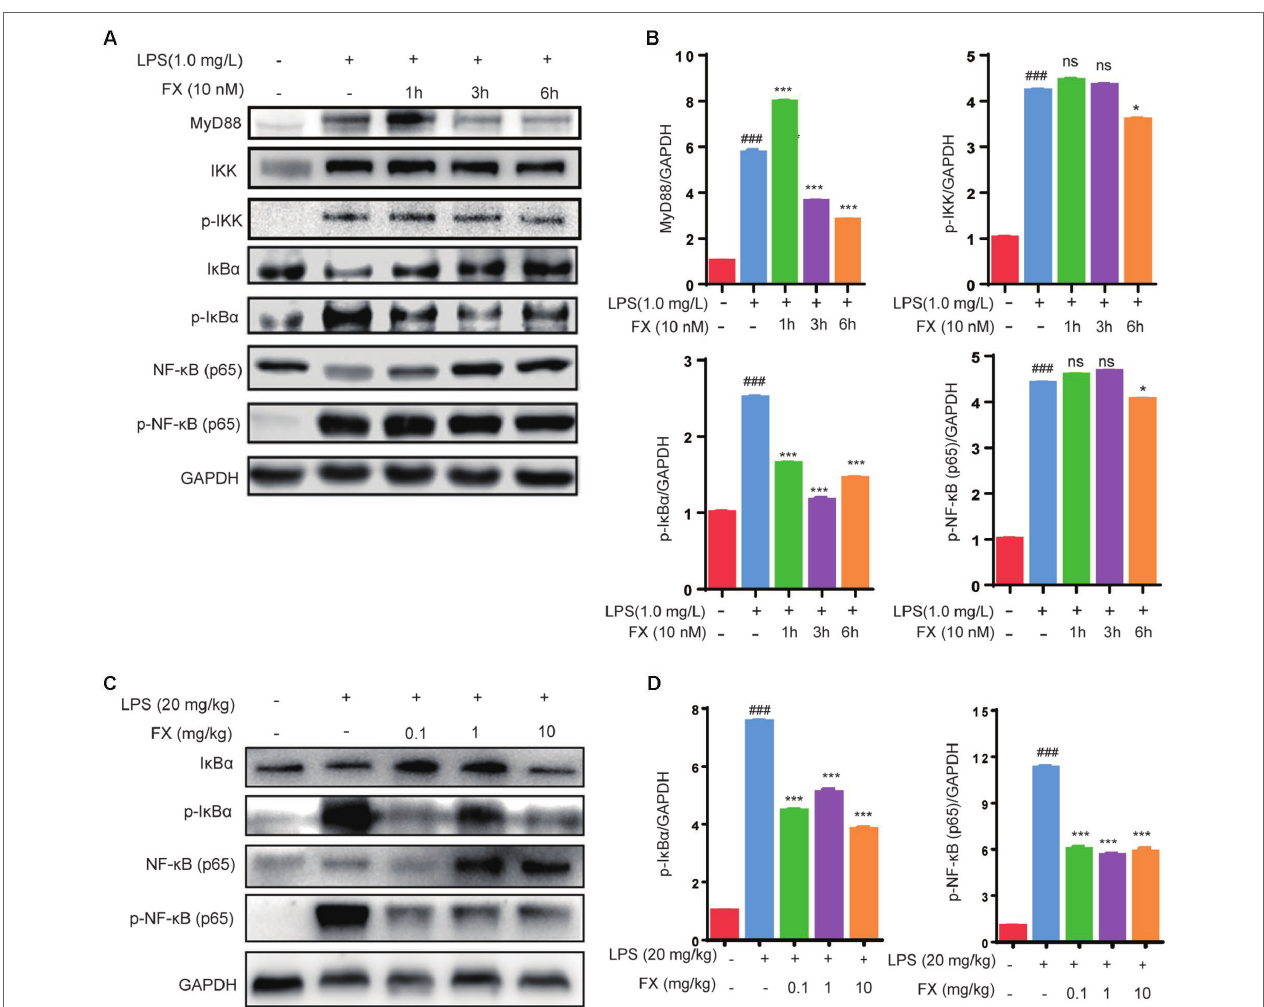
FIGURE 7 | Effects of FX on NF- Κ b signaling in LPS-treated RAW264.7 cells and LPS-treated mice. (A) Western blot analyses were performed to detect the levels of MyD88, IKK,p-IKK, I κ B α , p-I κ B α , NF- κ B (p65), and p-NF- κ B (p65) in LPS (1.0 mg/L)-treated RAW264.7 cells; (C) Protein levels of I κ B α , p-I κ B α , NF- κ B (p65) and p-NF- κ B (p65) in liver homogenates were evaluated by western blot analysis after LPS (20 mg/kg) challenge 6 h with or without FX treatment. (B and D) Densitometric analysis of the relevant bands was performed. The data were analyzed by the one-way ANOVA, followed by Tukey’s post hoc test. (###) p < 0.001, significantly different when compared with that of the control group. ( ∗ ) p < 0.05 and ( ∗∗∗ ) p < 0.001, significantly different when compared with that of the LPS group, ns: not significant. The data are representative of three independent